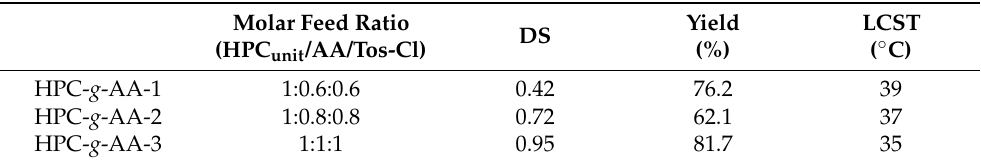
Figure 1. 1 H NMR spectra of ( A ) HPC; ( B ) abietic acid, and ( C ) HPC- g -AA. Table 2. HPC- g -AA characteristics with